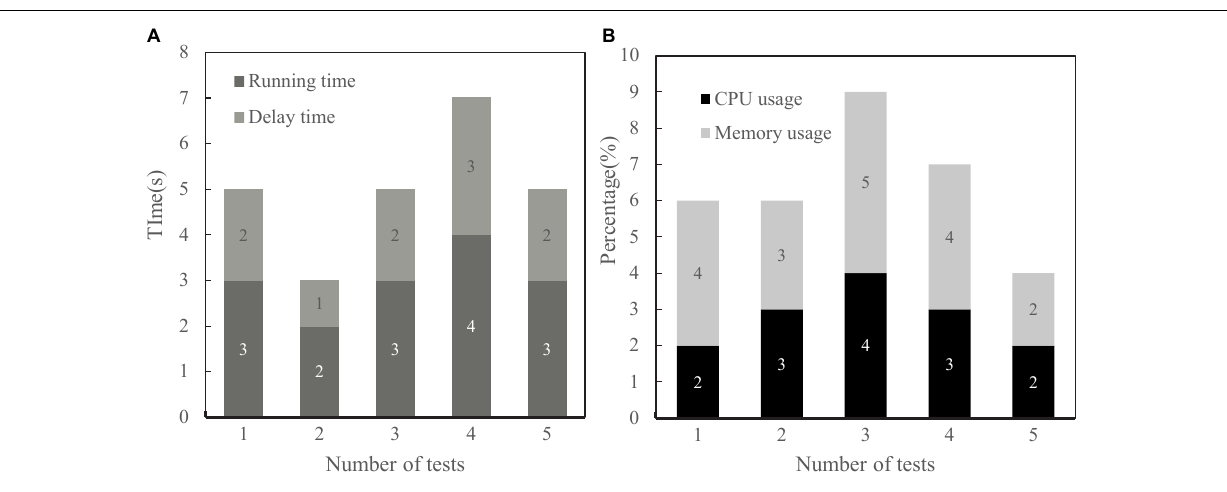
FIGURE 7 | The flow of people and the degree of financial self-service terminals of artificial intelligence. (A) Visitors flow-rate. (B) Degree of artificial